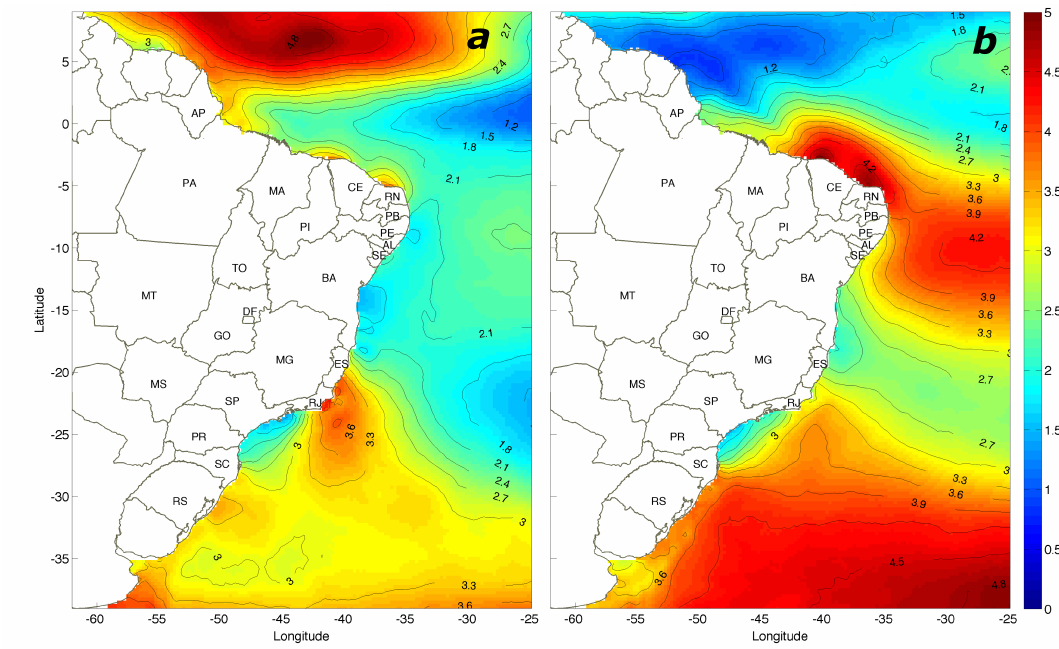
Figure 8. Climatological (1987-2014) turbine power P c for ( a ) January and ( b ) July for the height of z = 95 m, considering the Monin–Obukhov extrapolation method, the correction for air density and the SE 6.2 turbine power curve (see Section 2.5).